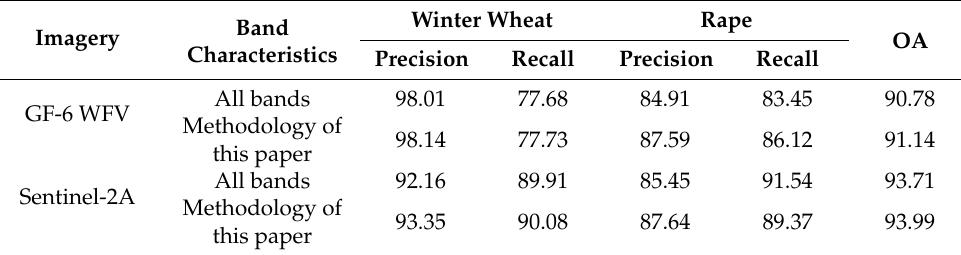
Table 10. Sensitivity comparison of vegetation index combination schemes for GF-6 WFV and Sen- tinel-2A data.